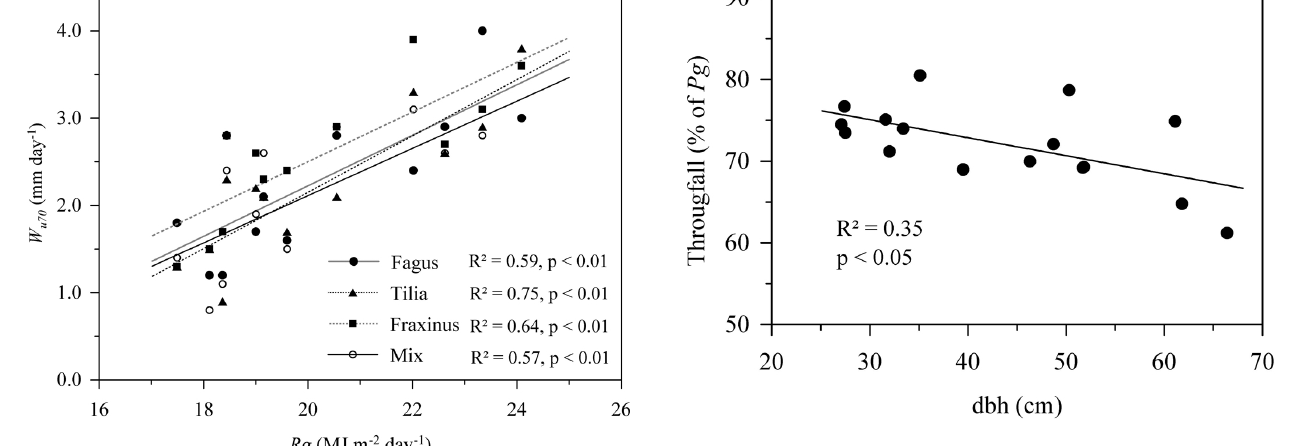
Figure 5. Relationship between average throughfall (% of gross precipitation, Pg ) and average cluster dbh during the soil desic- cation period (30 July to 1 September 2009). The equation reads Tf = 81 . 7 − 0 .